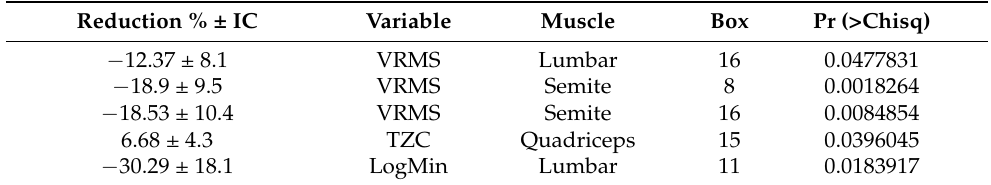
Table A1. Summary table where only the significant rows of the following five tables are shown. Values of p < 0.05 are considered significant.